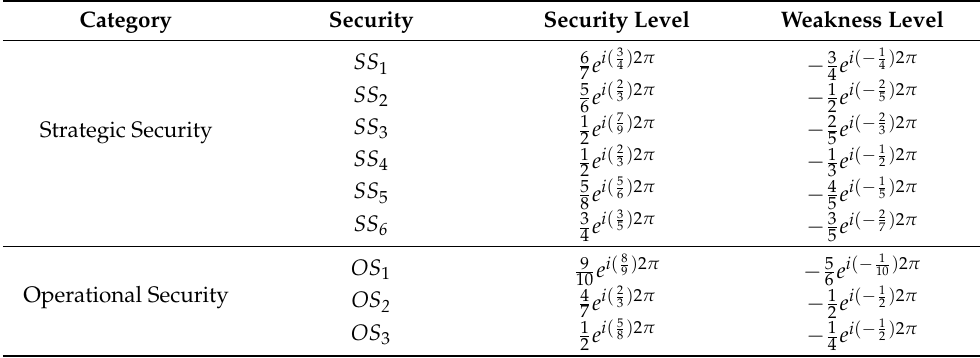
Table 3. Mathematical values for security